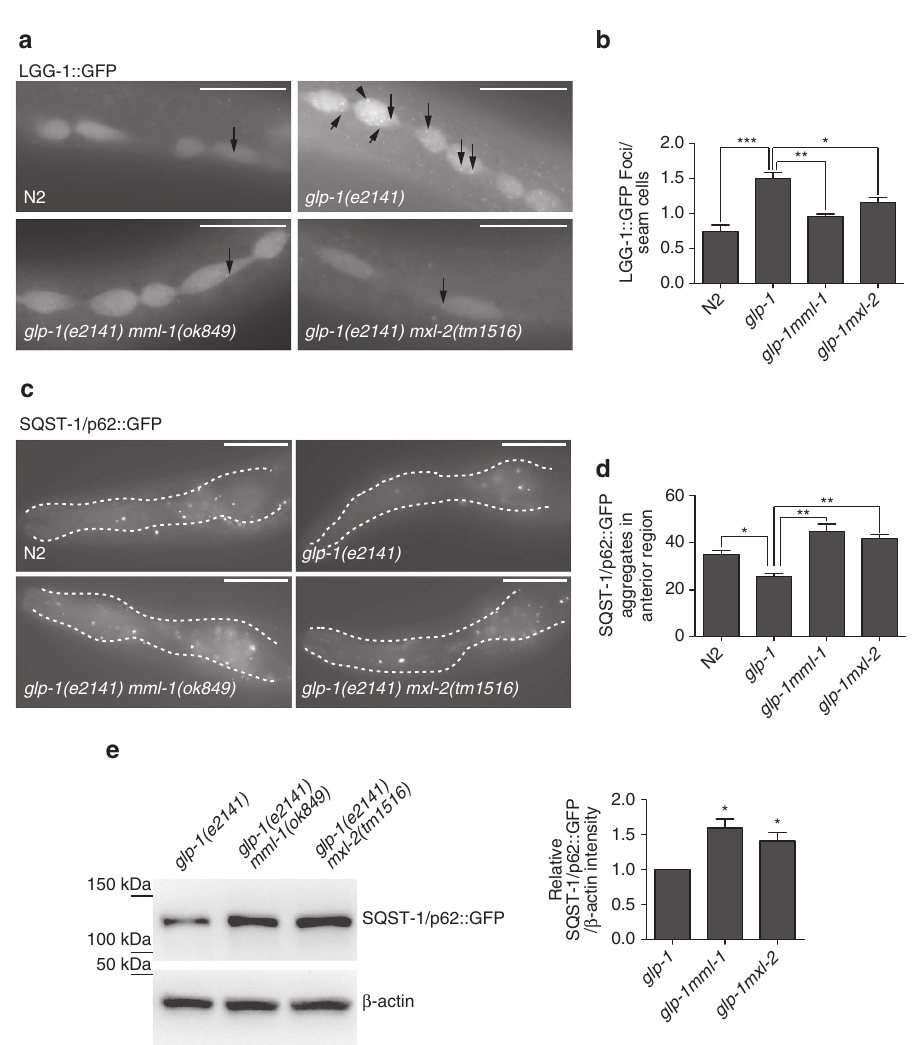
Figure 4 | MML-1/MXL-2 promote autophagy. ( a ) Representative fluorescent images of LGG-1::GFP foci in indicated genotypes at L4 stage. LGG-1::GFP puncta are reduced in glp-1mml-1 and glp-1mxl-2 compared with glp-1 . ( b ) Quantification of LGG-1::GFP puncta in seam cells. The bar represents mean ± s.e.m. from 3 biological replicates ( 4 20 worms each). P -value (* P o 0.05, ** P o 0.01) relative to N2 or glp-1 was determined by t -test. ( c ) Representative fluorescent images of SQST-1/p62::GFP transgenic worm of indicated genotypes at L4 stage. SQST-1::GFP aggregates are elevated in double mutants compared with glp-1 . ( d ) Quantification of SQST-1/p62::GFP foci in the pharyngeal region. The bar represents mean ± s.e.m. from 3 experiments ( 4 20 worms each). P -value (** P o 0.01) relative to N2 or glp-1 was determined by t -test. ( e ) Representative western blotting showing SQST-1::GFP and loading control, b-actin bands in indicated genotypes (left). SQST-1::GFP is elevated in glp-1mml-1 and glp-1mxl-2 . Quantification of SQST-1::GFP bands is shown (right). Bar graphs show mean ± s.e.m. relative to glp-1 from three independent experiments. Band intensity of SQST-1::GFP is normalized to loading control, b-actin. P- value (* P o 0.05) is determined by t -test relative to glp-1 . Scale bars, 20 m m. Figure 5 | MML-1/MXL-2 regulate HLH-30 via regulating TORC1 activity. ( a ) Western blot analysis of phosphorylation of p70 S6 kinase. Bars show mean ± s.e.m. of the band intensity relative to glp-1 from three experiments. The band intensity of p70 S6 kinase phosphorylation is normalized to b-actin. P -value (** P o 0.01 and *** P o 0.001) is determined by t -test relative to glp-1 . ( b ) Bars show the percentage of worms with HLH-30::GFP in the nuclei of intestinal cells at day 1 adult (mean ± s.e.m. from 3 biological replicates, 4 20 worms each). Each RNAi treatment is indicated. Knockdown of TORC1 but not TORC2 components rescues HLH-30 nuclear localization in glp-1mml-1 and glp-1mxl-2 . Worms of individual genotypes were fed with indicated RNAi from egg onwards and raised at 25 (cid:2) C. P -values (* P o 0.05, ** P o 0.01 and *** P o 0.001) were determined by t -test. ( c ) qRT–PCR analysis shows that lars-1 but not mars-1 is de-repressed in glp-1mml-1 . The bar represents mean ± s.e.m. from three biological replicates relative to N2. P -value (*** P o 0.001) was determined by one-way analysis of variance (ANOVA) with Tukey’s test relative to glp-1 . ( d ) Representative fluorescent pictures of LARS-1::GFP. LARS- 1::GFP is de-suppressed in glp-1mml-1 and glp-1mxl-2 . ( e ) Quantification of LARS-1::GFP in posterior intestinal cells of indicated genotypes. Bars indicate mean ± s.e.m. from 3 replicates ( 4 20 worms each). P -value (*** P o 0.001) is determined by t -test relative to glp-1. ( f ) Representative fluorescent pictures of HLH-30::GFP in indicated genotypes and RNAi treatments at day 1. lars-1 knockdown rescues HLH-30 nuclear localization in double mutants. ( g ) Percentage of worms with HLH-30::GFP in the nuclei of intestinal cells at day 1 adult (mean ± s.e.m. from 3 replicates, 4 20 worms each). Each RNAi treatment is indicated. ( h ) A representative western blotting showing phosphorylation of p70 S6 kinase and b-actin (left), and their quantification (right). lars-1 knockdown by RNAi significantly reduces the level of phosphorylation of p70 S6 kinase in glp-1mml-1 and glp-1mxl-2 background. The bar represents mean ± s.e.m. from three experiments. P -value (* P o 0.05 and ** P o 0.01) was determined by t -test. ( i ) mml-1 and mxl-2 are required for TOR knockdown- mediated longevity. TOR RNAi knockdown was conducted from the day 1 adult stage. Scale bars, 100 m m ( d ) and 50 m m ( f ). NATURE COMMUNICATIONS|7:10944|DOI: